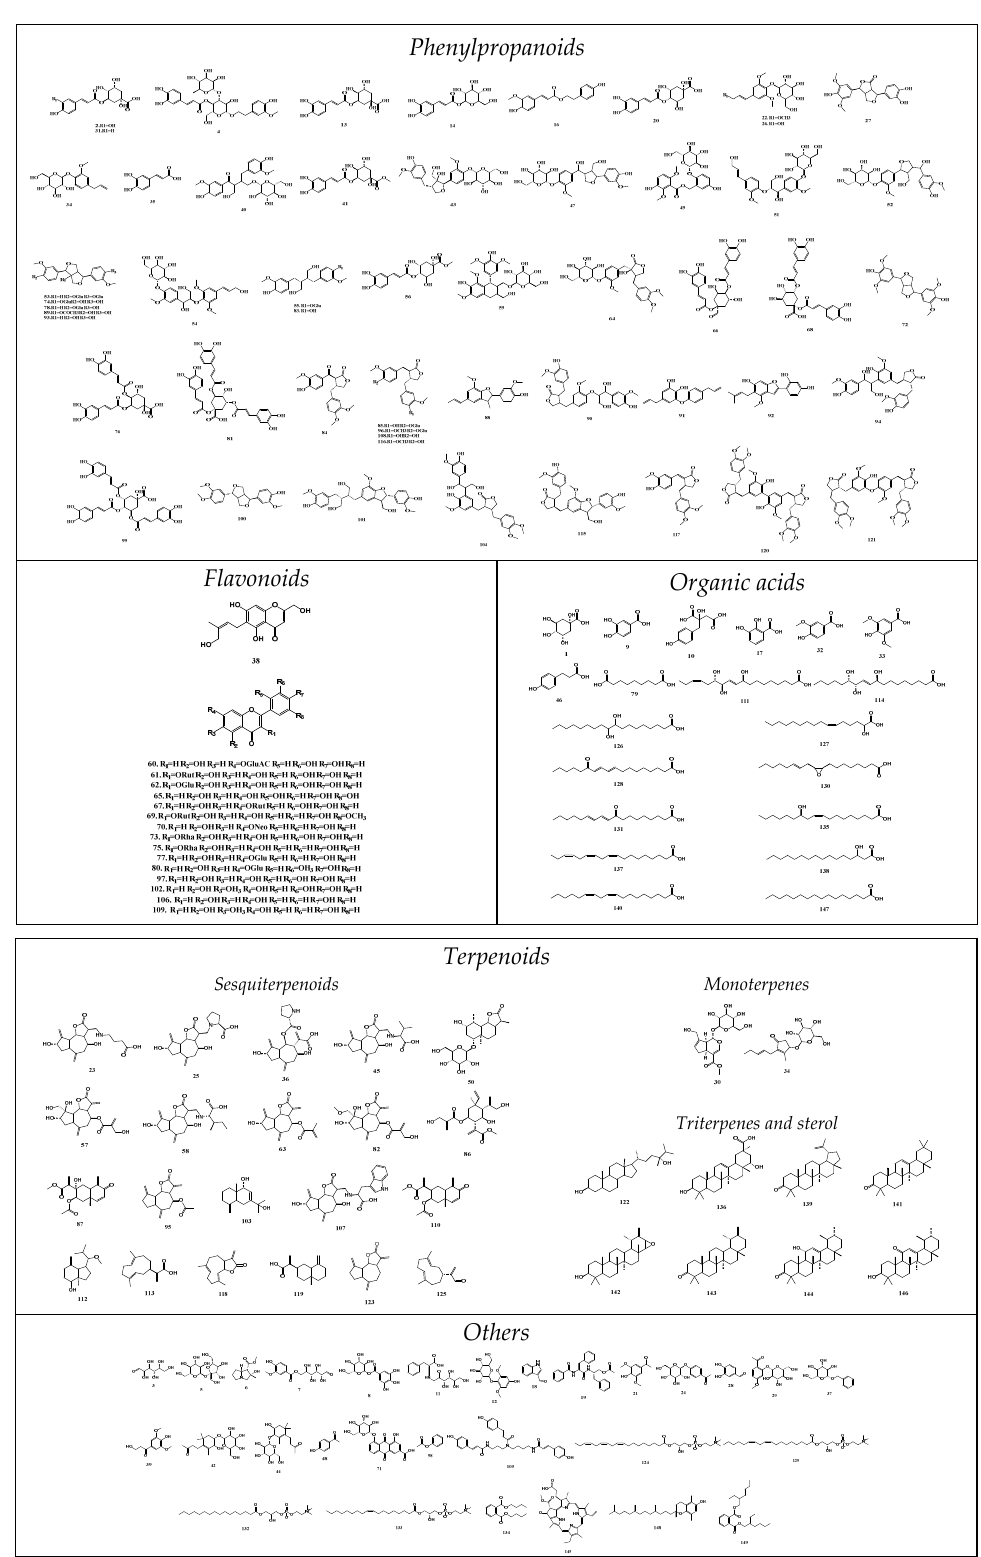
According to the types of chemical structure, these identified compounds could be divided into phenylpropanoids, flavonoids, terpenoids, organic acids and other types. The structures are listed in Figure 2.